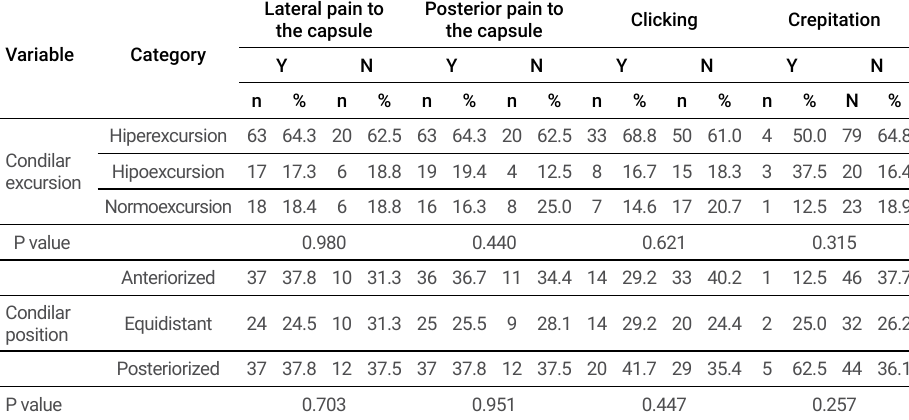
Table 5. Cross tabulation of the excursion estimates, condylar positions, articular signs and the significance of the chi-square test.